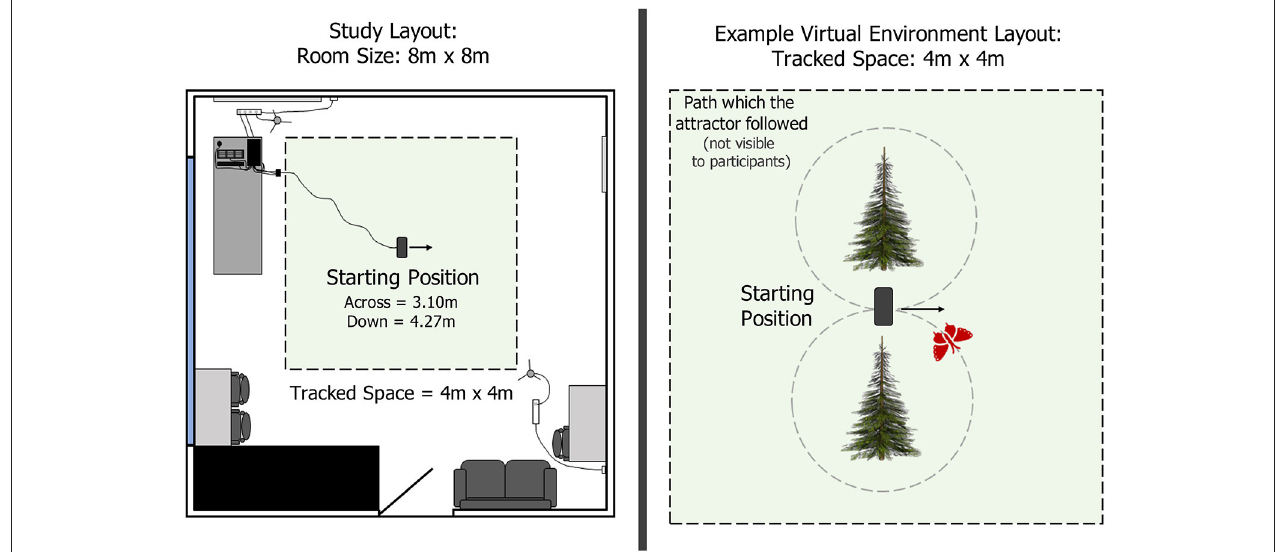
FIGURE 3 | Room and example virtual environment